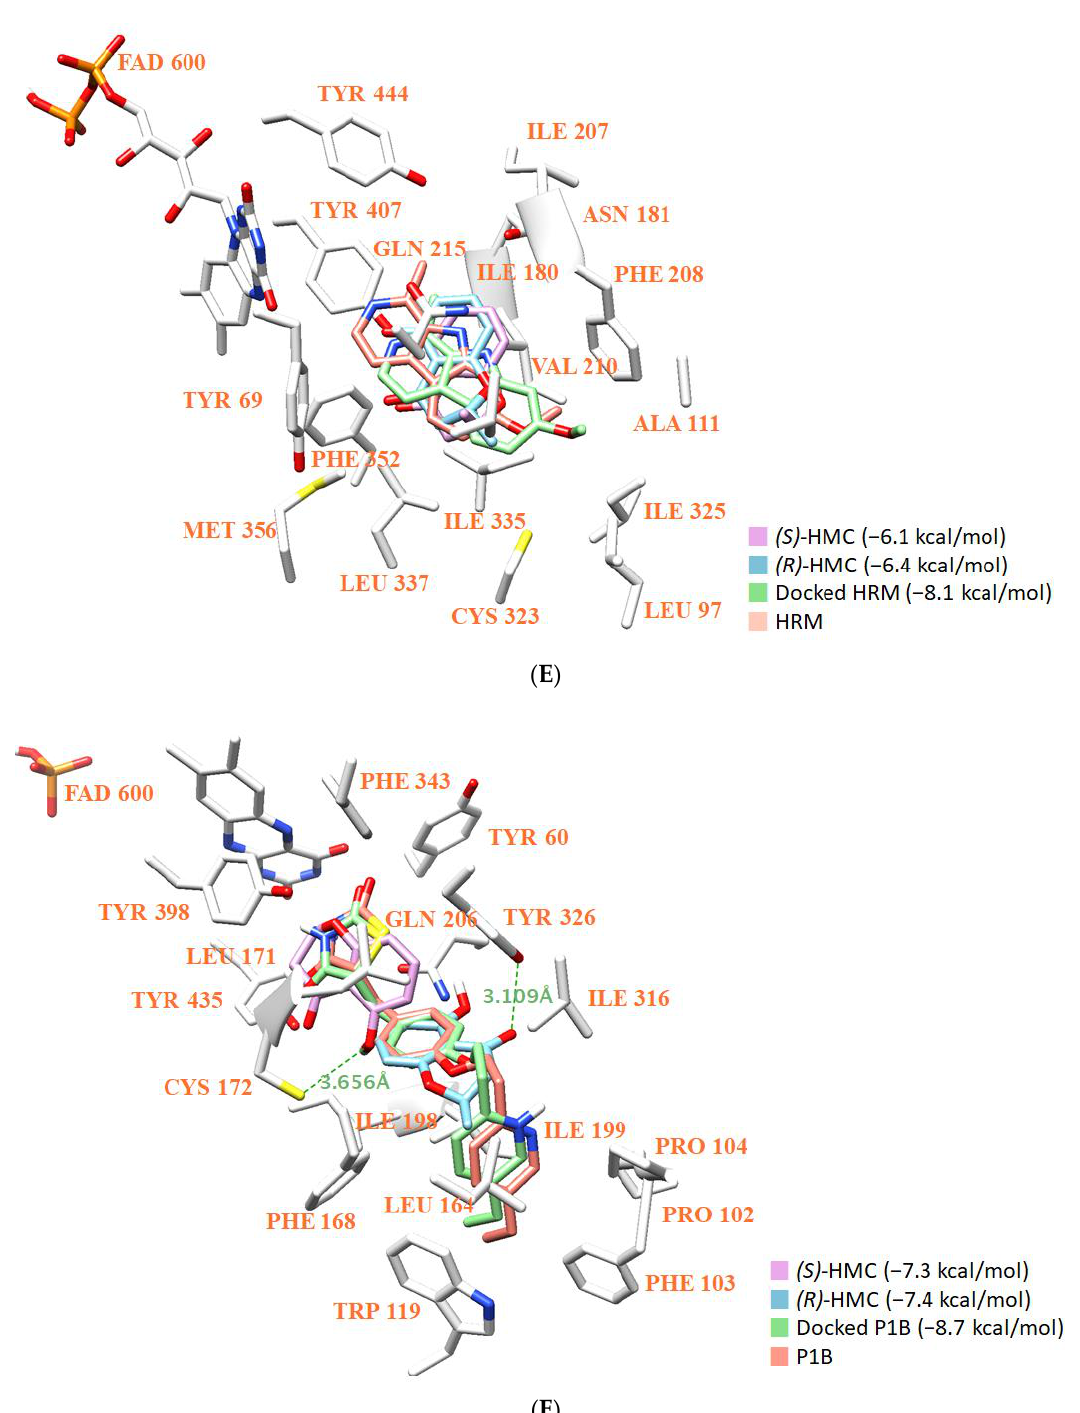
Figure 7. Docking simulations of ( S )- and ( R )-HMC to MAO-A ( A , C , respectively) and MAO-B ( B , D , respectively) and positioning of ( S )-, ( R )-HMC, docked, and co-crystallized ligands to MAO-A ( E ) and to MAO-B ( F ). MAO-A (PDB: 2Z5X) and MAO-B (PDB: 4A79) were subjected to docking analyses.